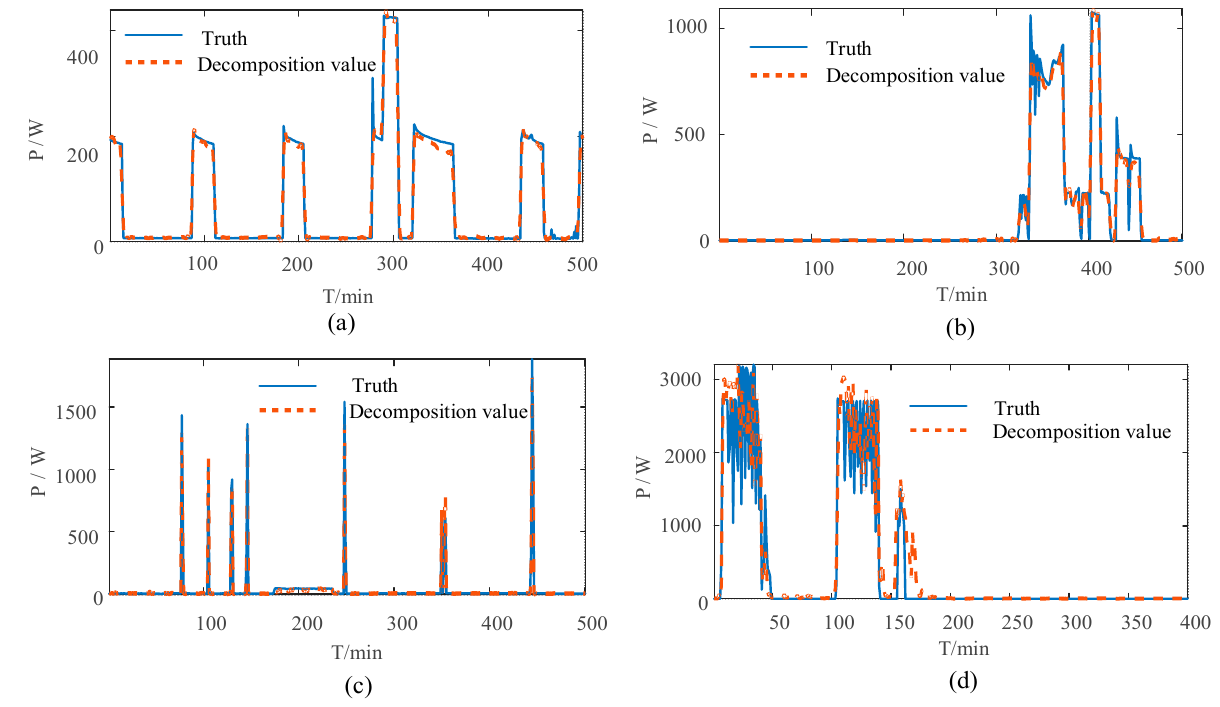
Figure 6. Example graph of experimental results of the same house ( a ) Refrigerator ( b ) Dishwasher ( c ) Microwave ( d ) Washing machine.